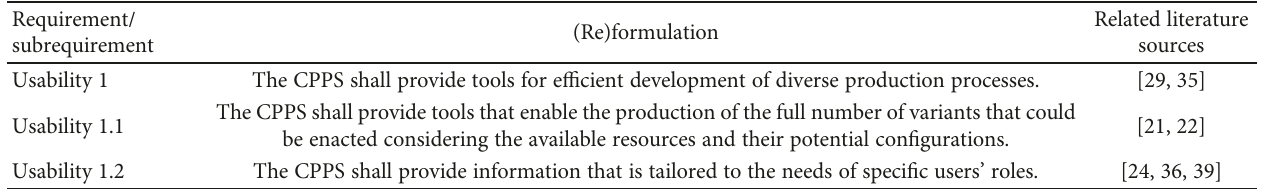
Table 5: Synthesis and reformulation of requirements on